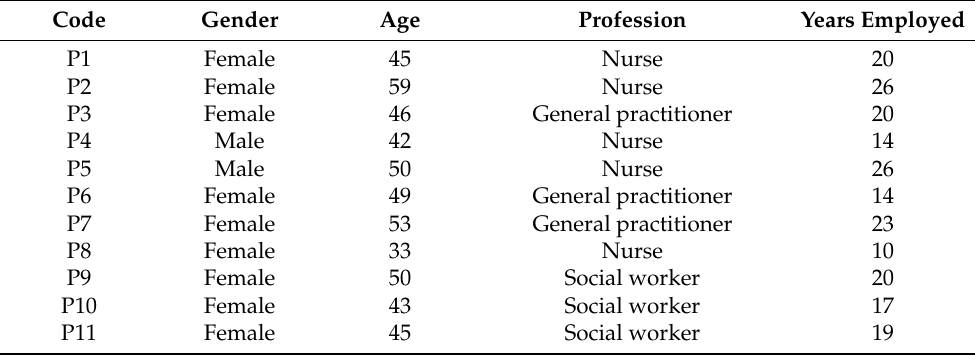
Table 1. Characteristics of the professional participants in the focus group.